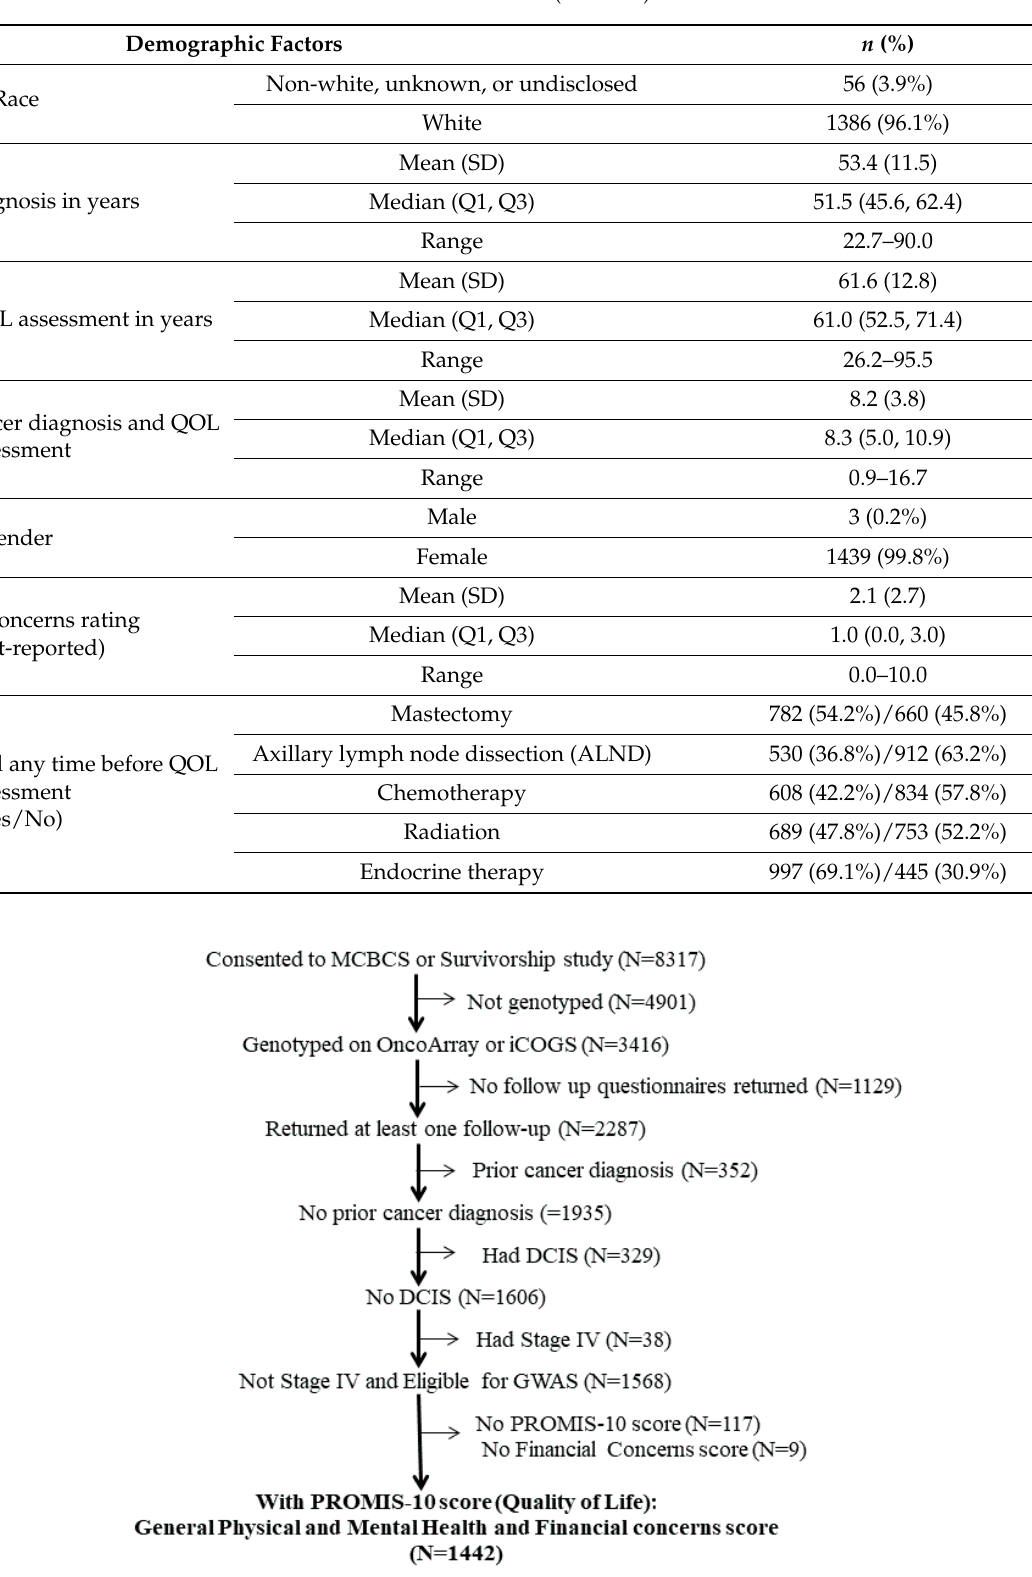
Table 1. Patient characteristics ( n = 1442).